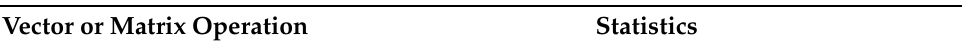
Table 23. Raspberry Pi IV benchmark statistics for vector and matrix operations with k = 32 (times in